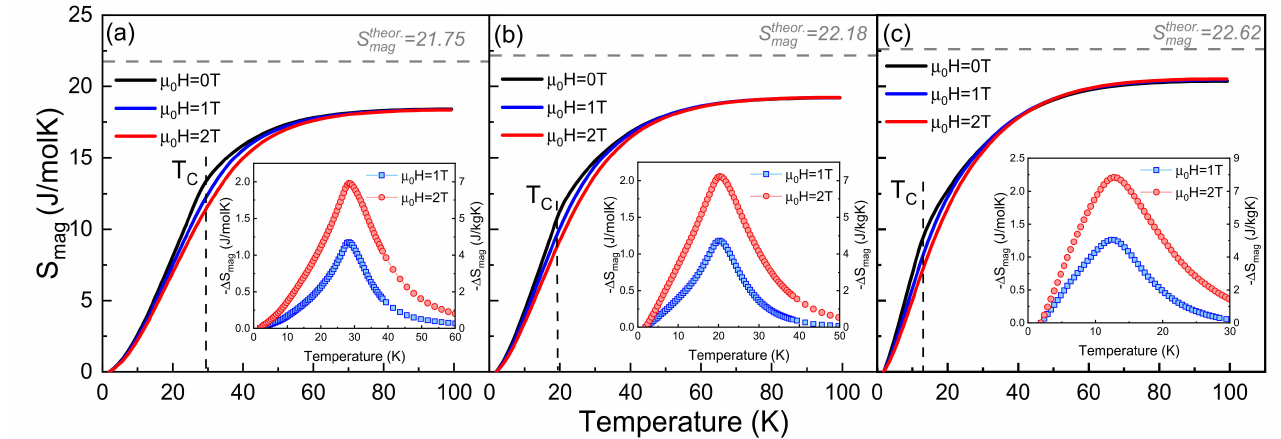
Figure 2. Temperature dependences of the magnetic entropy S mag ( T ) for Tb 0.75 Er 0.25 Ni 2 ( a );Tb 0.5 Er 0.5 Ni 2 ( b ); and Tb 0.25 Er 0.75 Ni 2 ( c ); in zero, 1- and 2 T magnetic fields. The horizontal dashed lines correspond to the theoretical maximum value S mag = Rln (2 J + 1), and the vertical dashed lines correspond to the magnetic phase transition temperature T C . Insets show the magnetic entropy change − ∆ S mag ( T ) measured for the magnetic field changes of 1 and 2